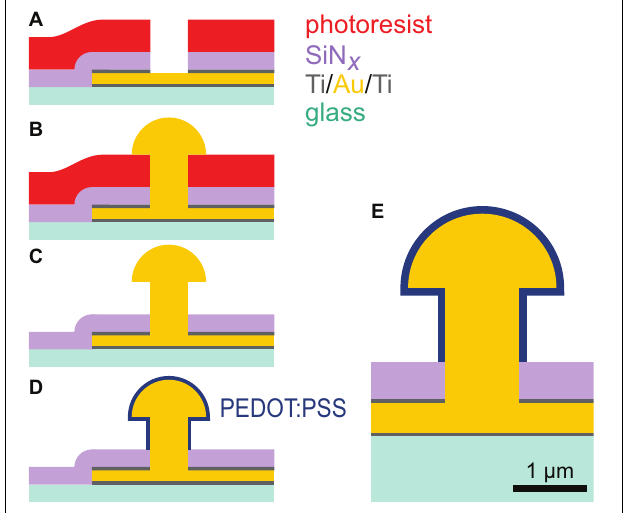
FIGURE 1 | Fabrication of PEDOT:PSS ultramicroelectrodes. Conducting traces (300 nm of Ti/Au/Ti) and a SiN x insulator (400 nm thick) were patterned on glass substrates (A) . The photoresist mask ( ∼ 2 µ m) for etching of the insulator was additionally used as the electroplating template, although etching reduced its height (B) . Removal of photoresist produced a 3D gold ultramicroelectrode (C) . Electrodeposition of PEDOT:PSS produced a conformal coating approximately 100 nm thick (D) . Our targeted shape was 3D with a stalk diameter of 1 µ m and head diameter of 2 µ m (E) . This drawing shows ideal geometries and illustrative